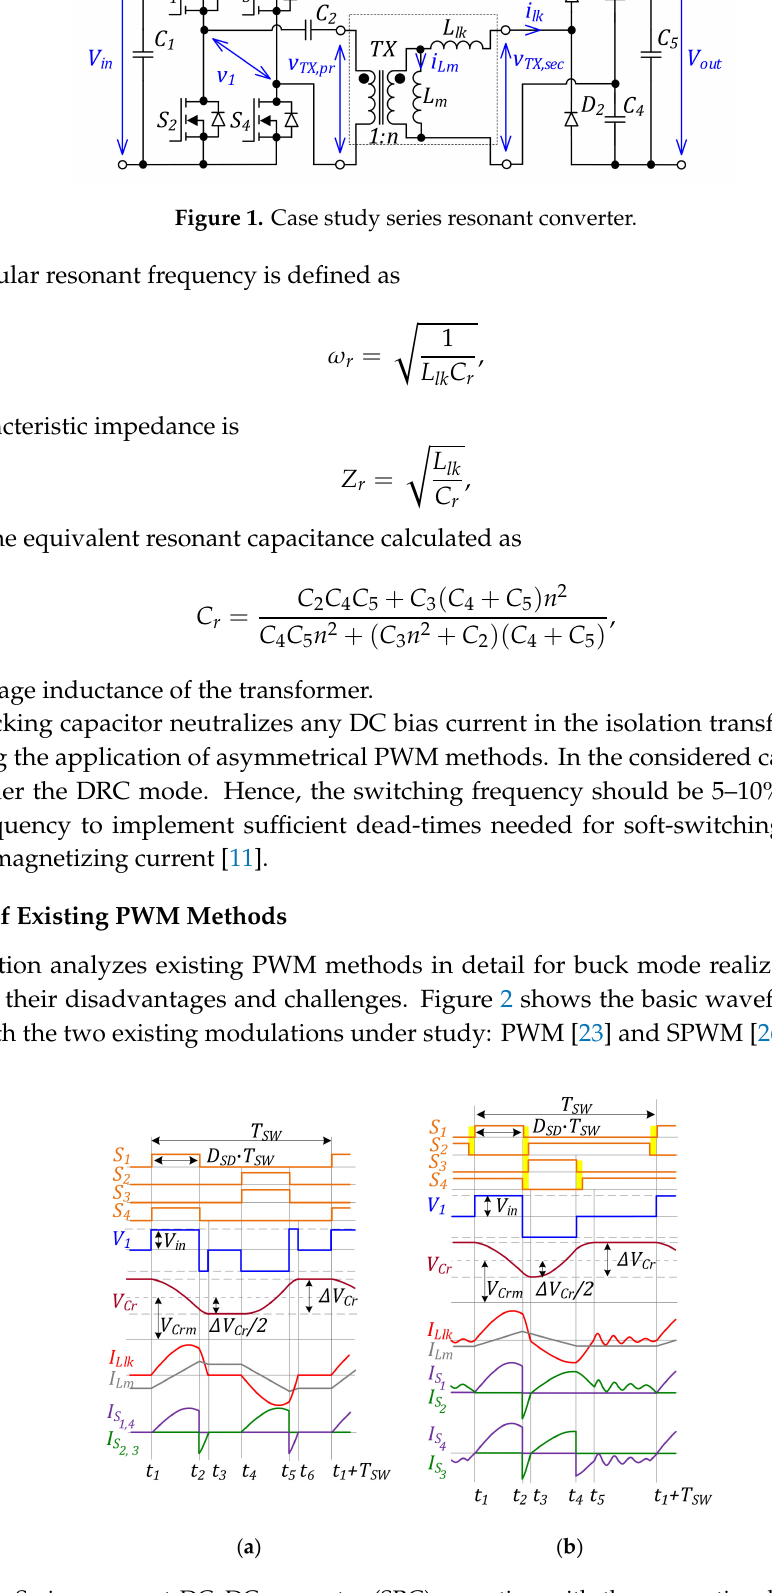
Figure 2. Series resonant DC–DC converter (SRC) operation with the conventional pulse-width modulation (PWM) [23] ( a ) and shifted pulse-width modulation (SPWM) [26] ( b